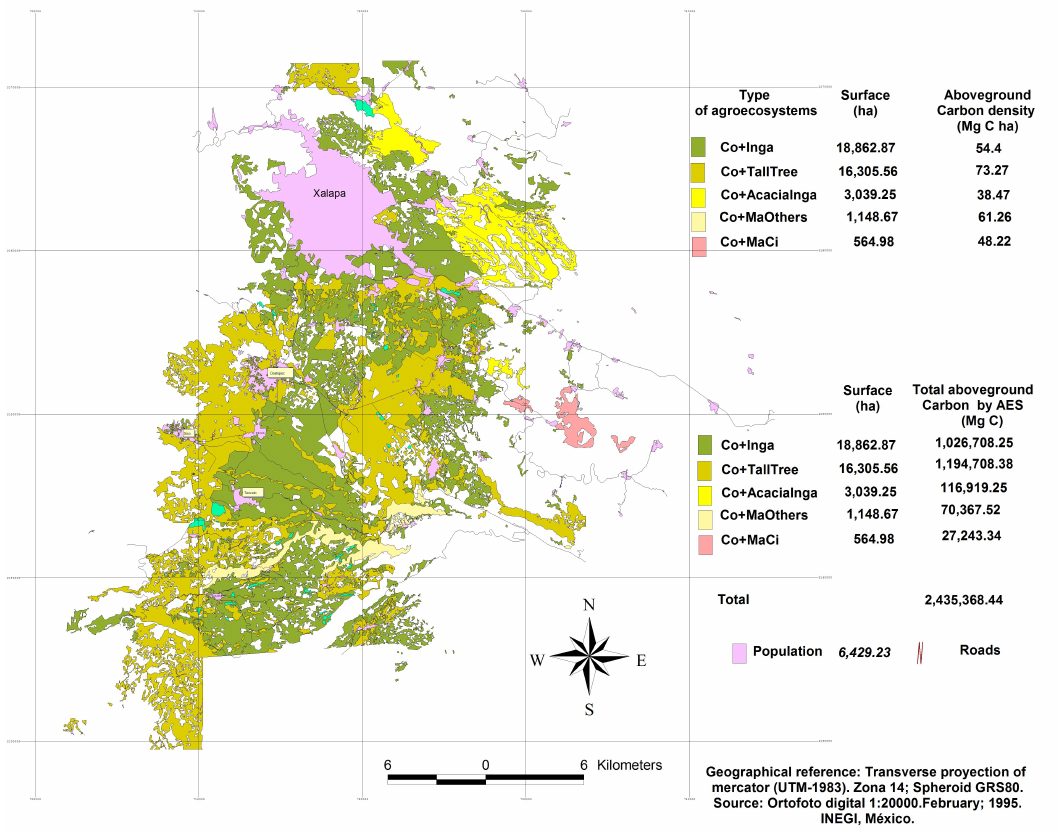
Figure 4. Spatial distribution of C density (Mg C ha − 1 ) by type of coffee agroecosystem (AES) in the central region of the state of Veracruz,